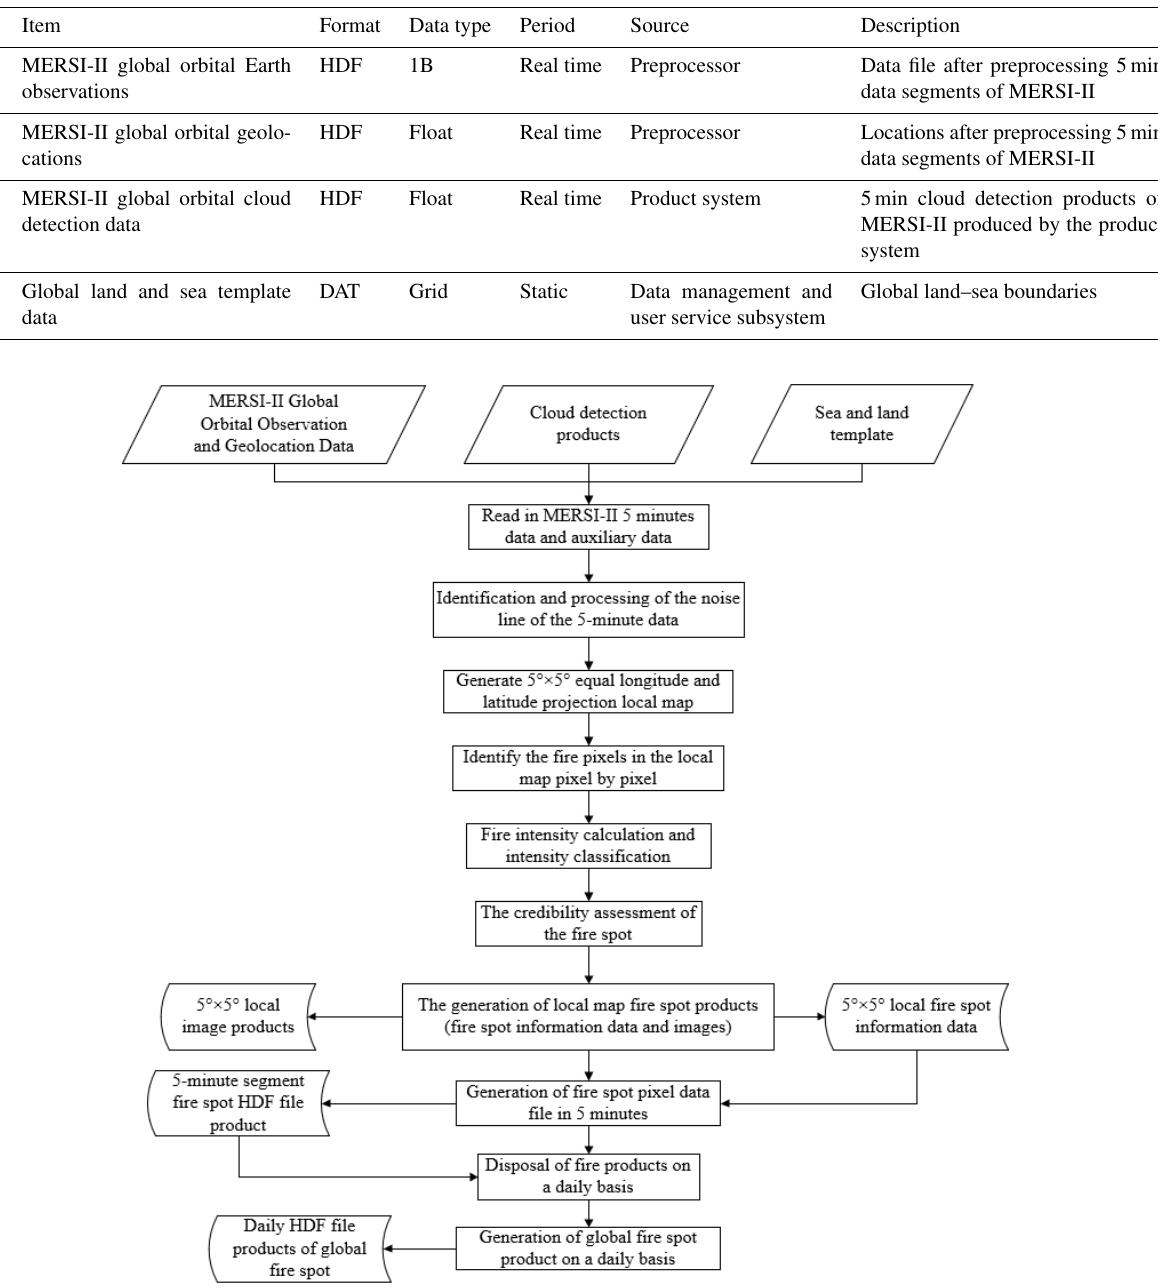
Table 2. Input file list of MERSI-II global fire monitoring software.